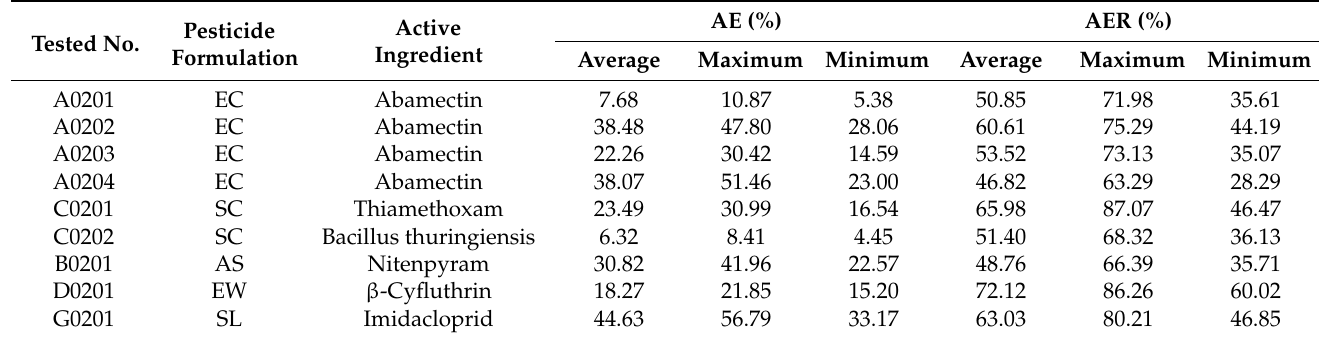
Table 4. Actual emission ratio of total VOCs during applied typical insecticides.